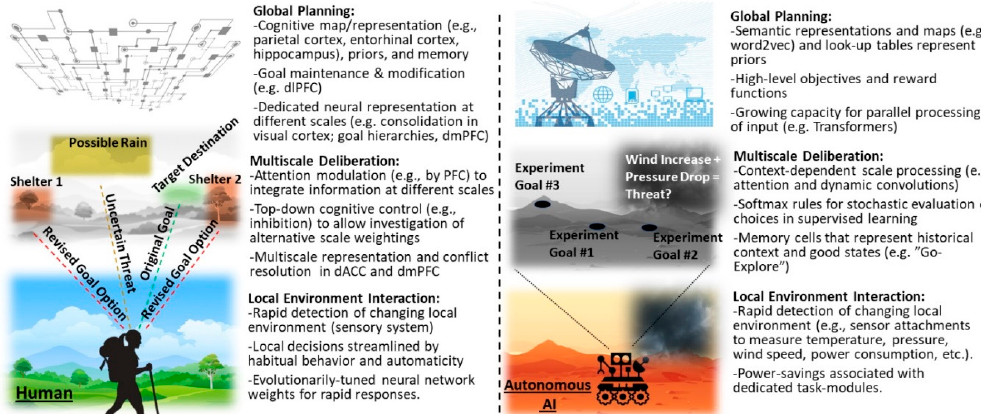
Figure 8. Comparing the Computational Architecture for Navigating Uncertain Environments of Human Brains and the Frontier of Autonomous AI Systems. (Left) Human brains have a highly flexible and generalizable learning architecture. Evolutionarily tuned biological networks allow for streamlining or even “automation” of local tasks and decision-making through biases and habituation, while cognitive maps and detailed prior knowledge within long-term memory allow for multiple goal tracking. Both top-down and bottom-up attentional processes modulate cognitive resources and deliberate across multiple spatio-temporal scales, while an agent pursues goals and makes inferences within dynamic and uncertain environments. (Right) Current AI systems have made tremendous progress towards comparable or even super-human computational and task-related performance in many controlled environments. AI already have the ability to simultaneously consider much larger amounts of sensory data and meta-data than human brains, with much larger-scale parallelization than biological brains, such as in Transformer networks. Thus, improved world models, more computationally efficient and robust multiscale attentional algorithms, and more flexible multiscale deep neural net structures that provide higher sample efficiency and accuracy hold great promise for achieving successful autonomous AI systems. Distinguishing between single and multiscale computational processes is still rare in behavioral and neural sciences with regards to exploration and exploitation, but recognition is growing in the importance of considering this topic. Understanding the balance of these multiple competing and/or complementary computational layers underlying multiscale decision making (which may actually be the dominant form of decision making in humans) is a crucial problem for studies of information processing of the brain in the upcoming decade. Moreover, as described above, it is being increasingly incorporated into AI. One area we have barely touched on is the necessity for intelligent systems to escape local minima in the fitness or value space. For example, imagine the animal in Figure 1 trapped permanently at a suboptimal peak. Current uncertainty reduction models have the weakness of not adequately explaining or predicting what drives humans to break out of habits or biases (such as creating temporally local increases in uncertainty) [197,198,199]. These are drives which presumably include a desire for creating a long-term reduction in global uncertainty. Biological attentional processes may also play a critical role in this area, especially in non-reinforced preference or state changes [200]. Thus, it is an open and important question in multiscale neuroscience as to what motivates humans to embark on risky exploratory behavior by temporarily increasing local